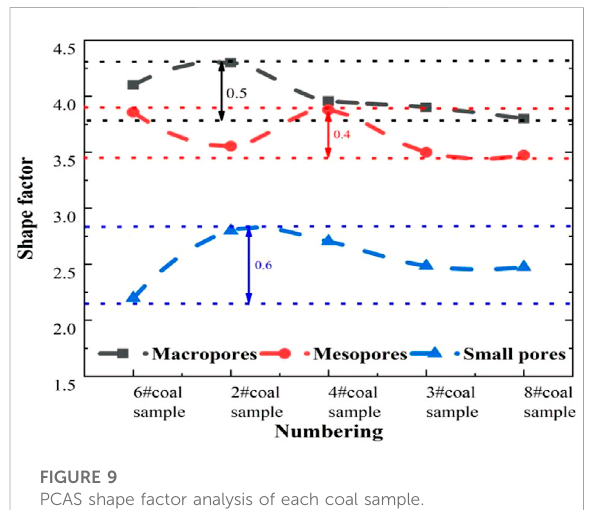
FIGURE 9 PCAS shape factor analysis of each coal